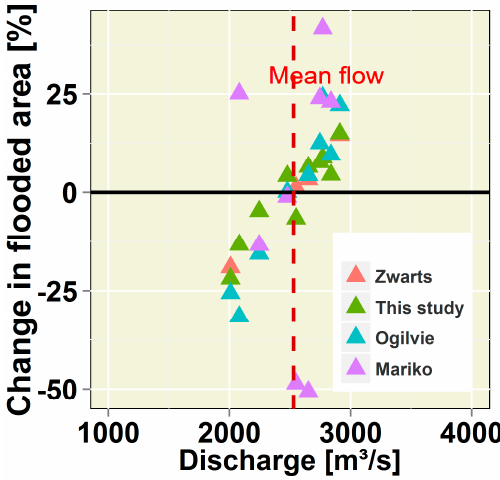
Figure 8. Remote sensing estimates of the flooded surface areas and peak flow discharge at Mopti perceptions of relative mean flooded area change at NID; Points show percentage of change in flooded area response with increase in flow.